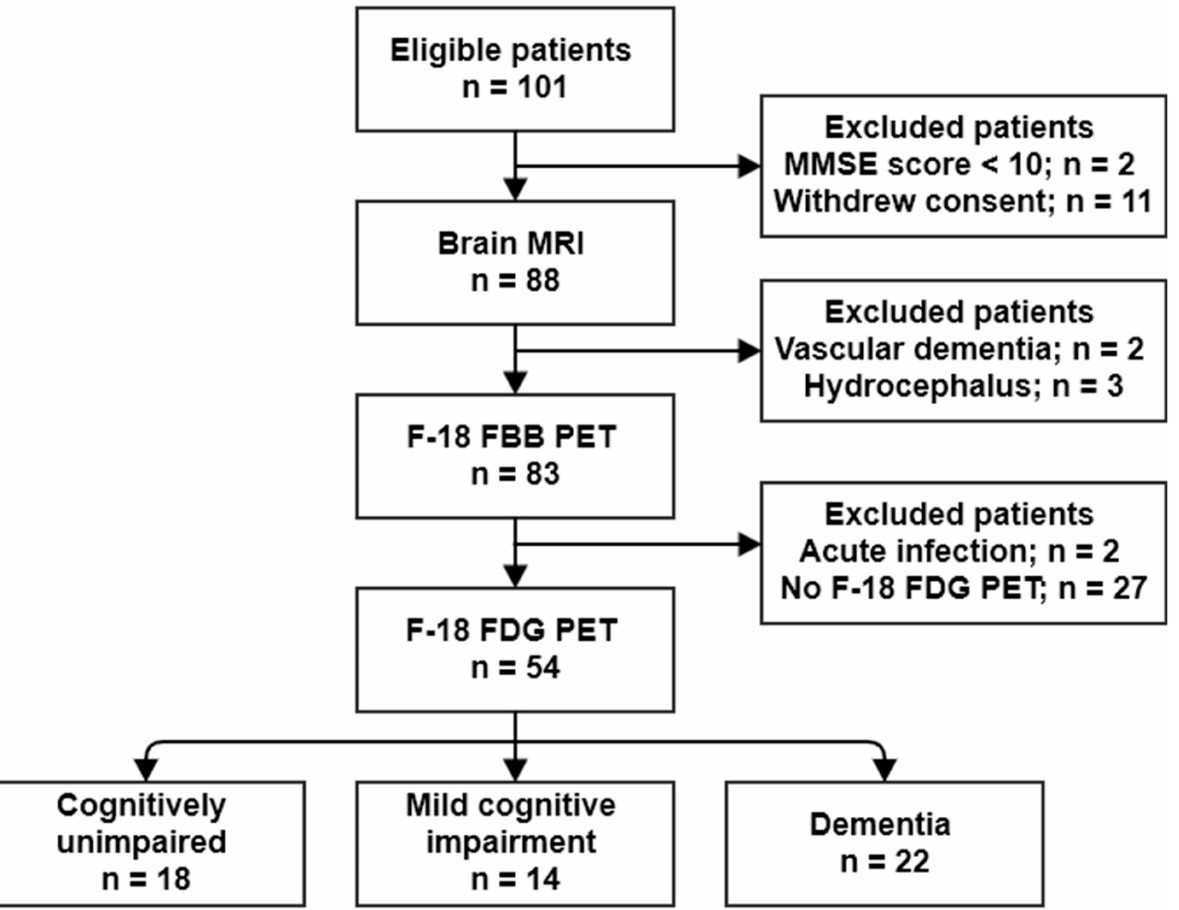
Figure 1. Flow diagram of the study